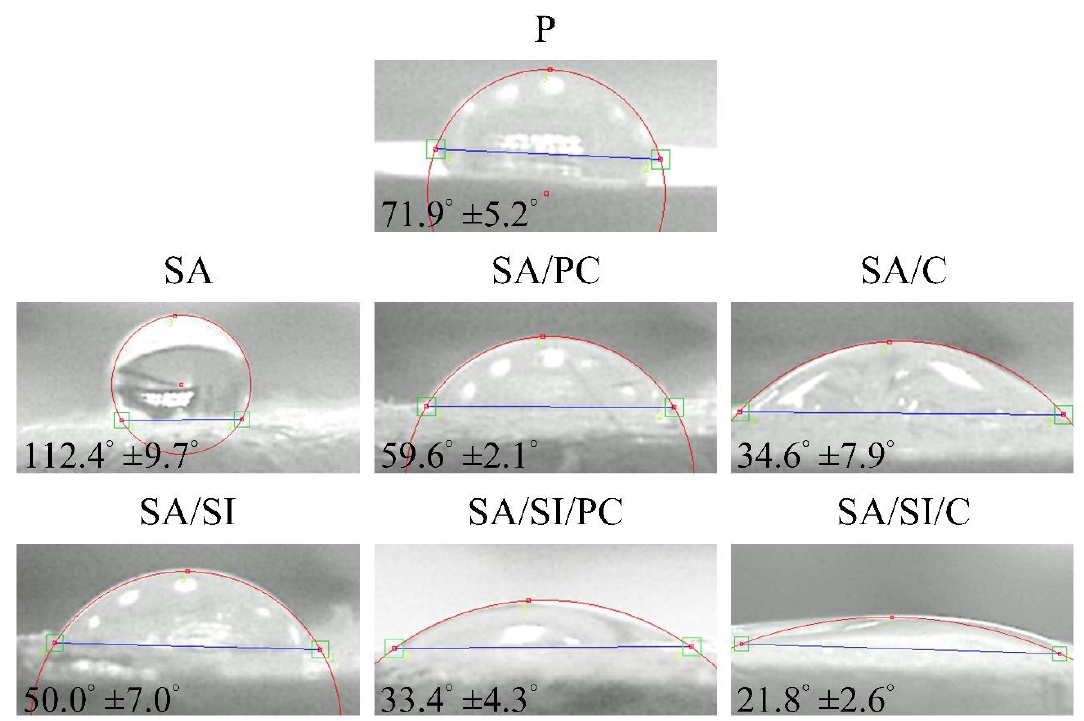
Figure 4. Wetting angles of different surface-modified PEEK hydrophilicity tests ( n = 5) .